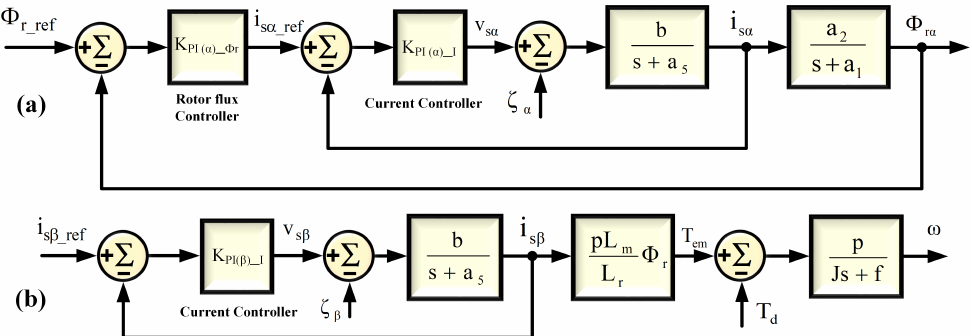
Figure 4. ( a ) Control scheme of rotor flux for the α -axis. ( b ) Current controller for i s β component on the β